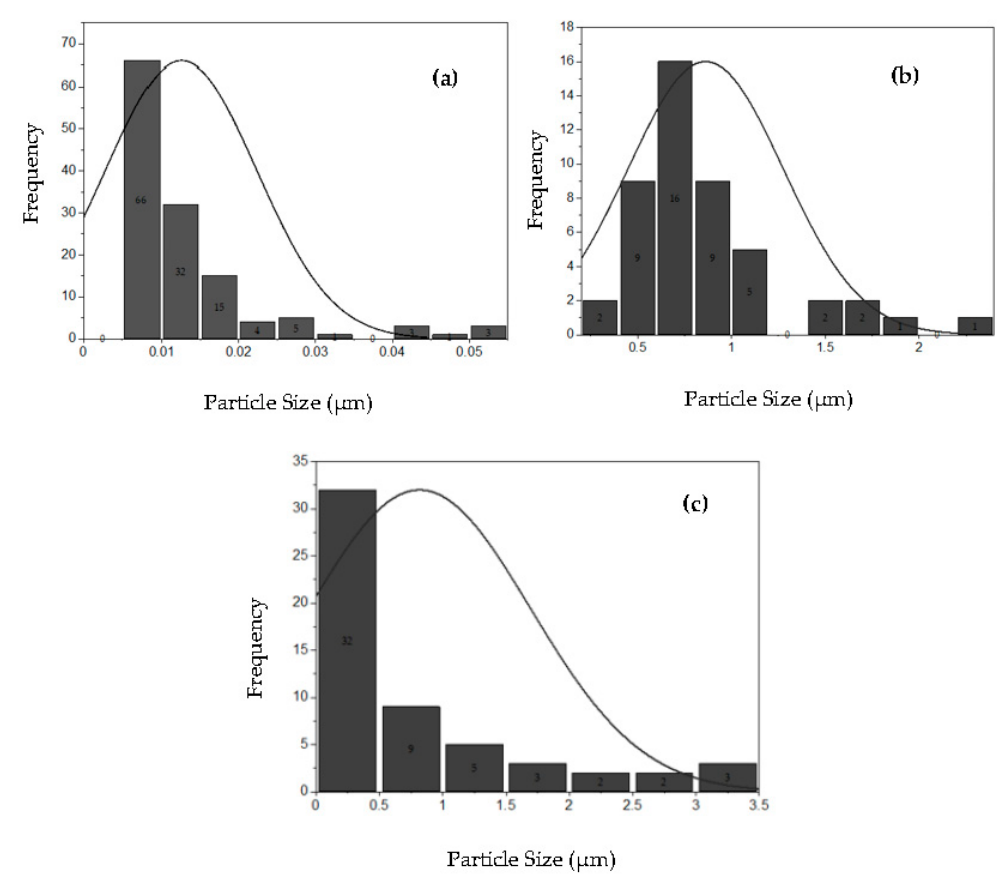
Figure 7. Histograms of particle size distribution measured by the SEM/ImageJ analysis. ( a ) Zr; ( b ) Ni size distribution within the catalyst sample; ( c ) milled MgH 2 .